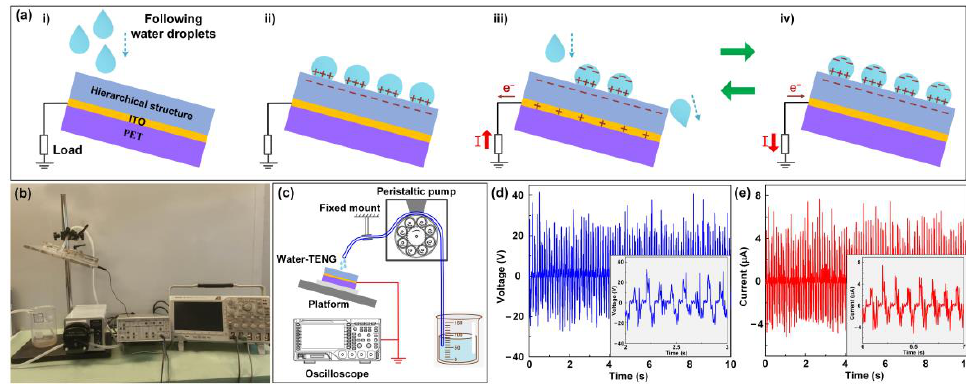
Figure 4. ( a ) Working mechanism of TENGs based on hierarchical structure and flowing water droplets. ( b ) Photograph and ( c ) schematic illustration of testing setup for water-TENGs. Typical output ( d ) voltage curve and ( e ) short-circuit current curve of the hierarchical structure-based water-TENG at a flowing velocity of 8 mL/s, the inset figures show the enlarged views.